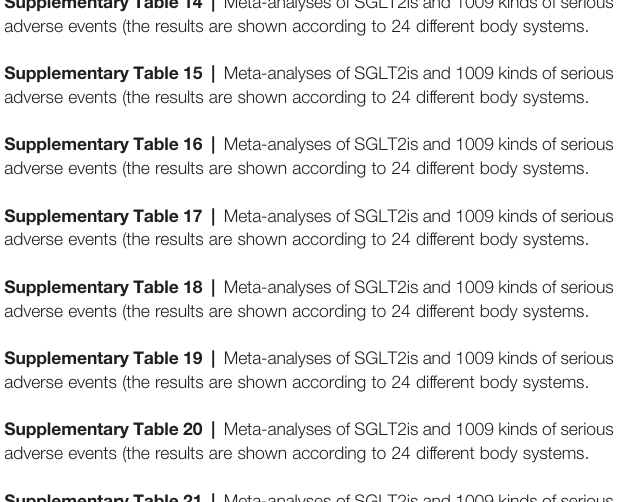
Supplementary Table 4 | Meta-analyses of SGLT2is and 1009 kinds of serious adverse events (the results are shown according to 24 different body systems. Supplementary Table 5 | Meta-analyses of SGLT2is and 1009 kinds of serious adverse events (the results are shown according to 24 different body systems. Supplementary Table 6 | Meta-analyses of SGLT2is and 1009 kinds of serious adverse events (the results are shown according to 24 different body systems. Supplementary Table 7 | Meta-analyses of SGLT2is and 1009 kinds of serious adverse events (the results are shown according to 24 different body systems. Supplementary Table 8 | Meta-analyses of SGLT2is and 1009 kinds of serious adverse events (the results are shown according to 24 different body systems.